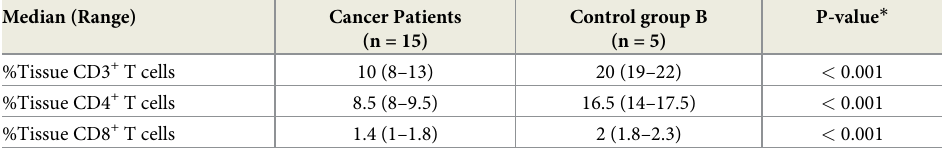
Table 5. The differences in tissue T-cell subsets between patients and controls.